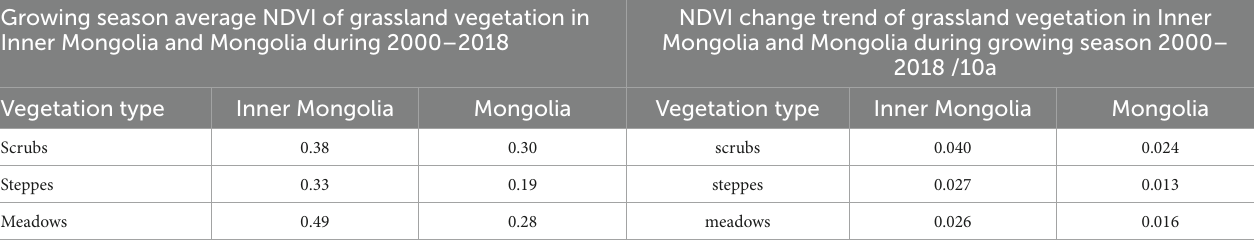
NDVI change trend of grassland vegetation in Inner Mongolia and Mongolia during growing season